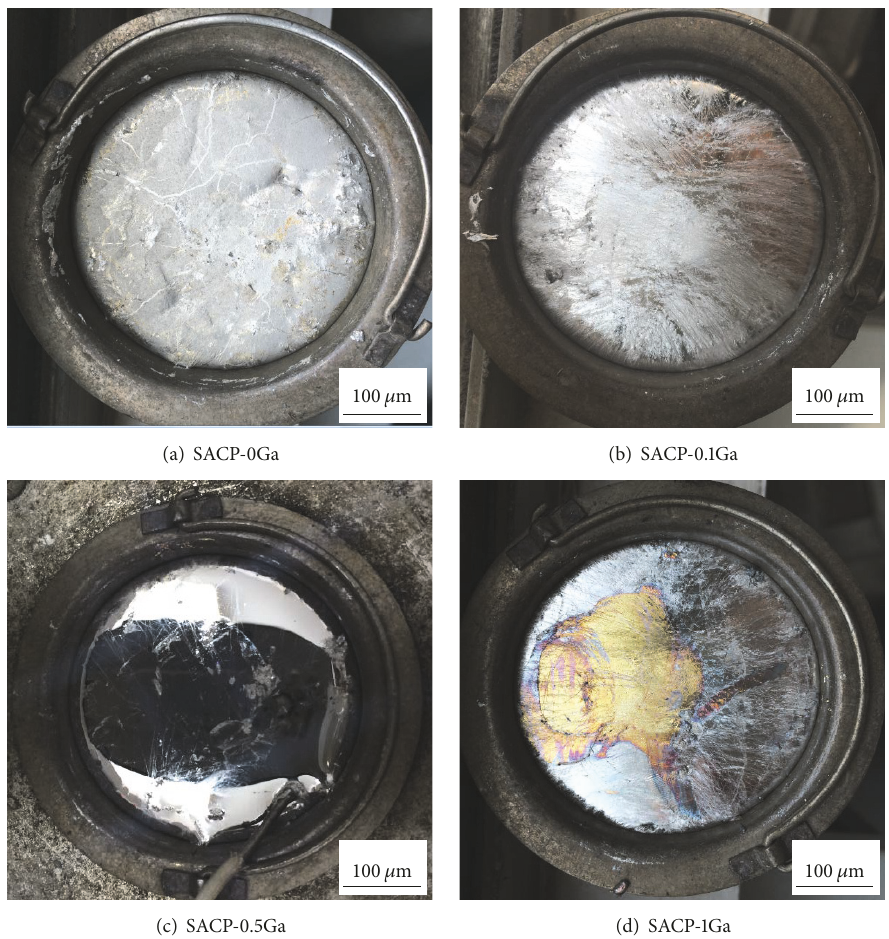
Figure 7: The surface morphology photographs of solders after incubation at 245 ∘ C for 30 min.